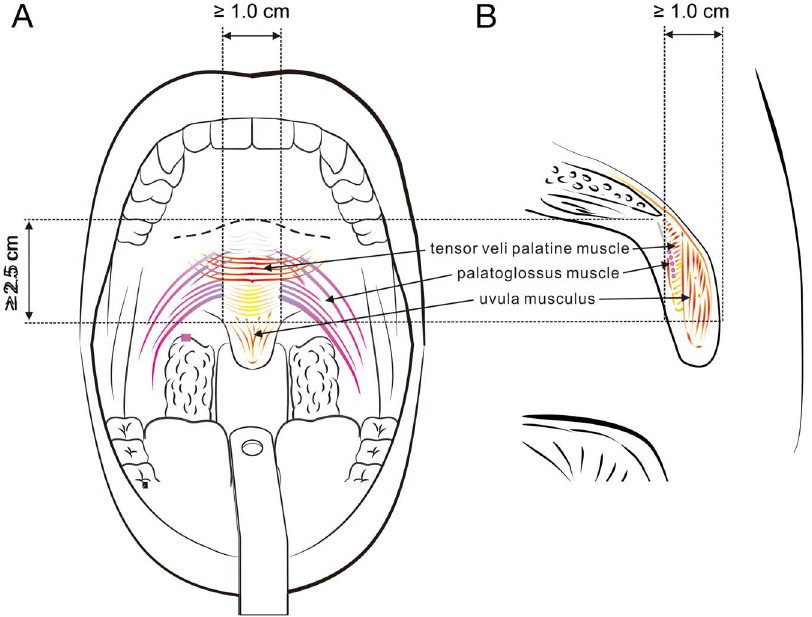
Figure 2. Favorable anatomy for the MIS of the soft palate in anti-snoring treatment. (A) Frontal view showing the longitudinal length from the uvular base to the hard palate-soft palate junction $ 2.5 cm and the lateral width of the uvular base $ 1.0 cm. (B) Lateral view illustrating the anterior-posterior width of the uvular base $ 1.0 cm.